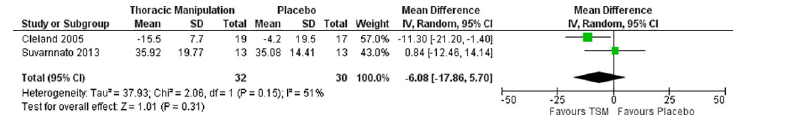
Fig 2. Meta-analysis of TSM versus placebo TSM for pain at immediate follow-up.